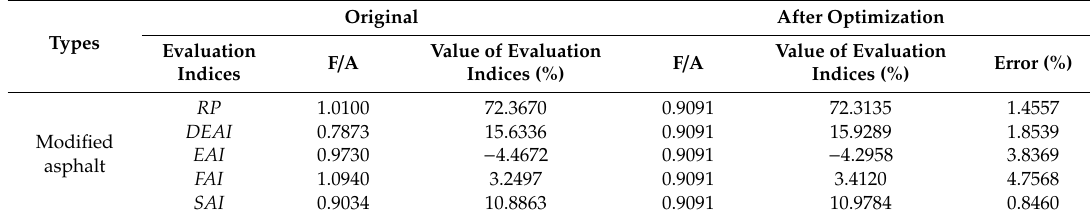
Table 8. Results of unified optimal F / A of modified asphalt mortar.